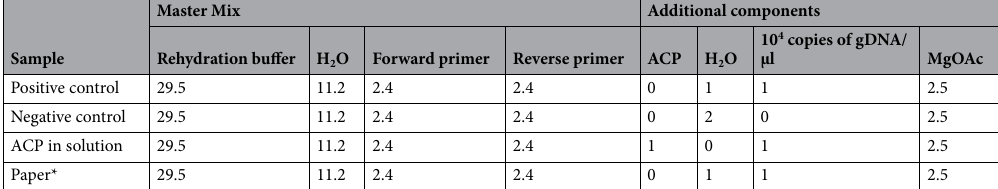
Table 2. Volumes for each component present in RPA reactions for experiments in Fig. 3A,C, Fig. S4A,B. Volumes for each component present in RPA reactions in microliters. *Nitrocellulose paper plain for Fig. S4, or with dried ACP for Fig. 3A,C.